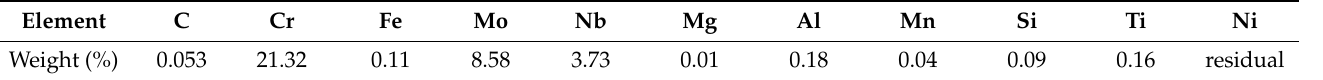
Table 1. Chemical composition of Inconel 625